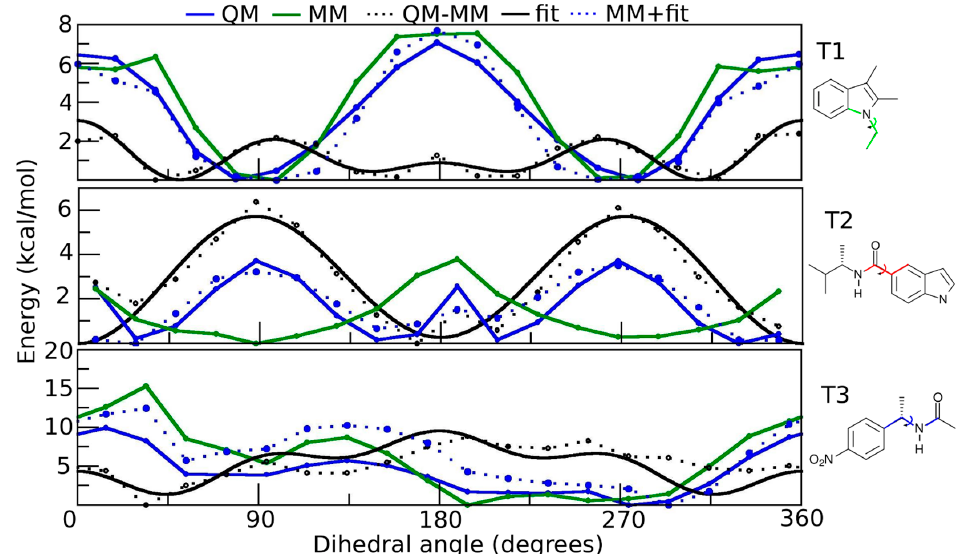
Figure 2. Potential energy curves generated for the torsions T1, T2, and T3 of the SR1664 molecule. The values of the potential energy computed by density functional theory are represented by the blue line (QM), whereas the corresponding values generated from the classical potential are represented by the green line (MM). The QM and MM energy differences are depicted by the black dotted line; the solid lines are the fitted dihedral potentials; the blue dotted lines are the sum MM and fitted dihedral potential. The structures on the right side of each graph depict the fragments used to calculate the potential energy curves (the calculated dihedrals are colored).